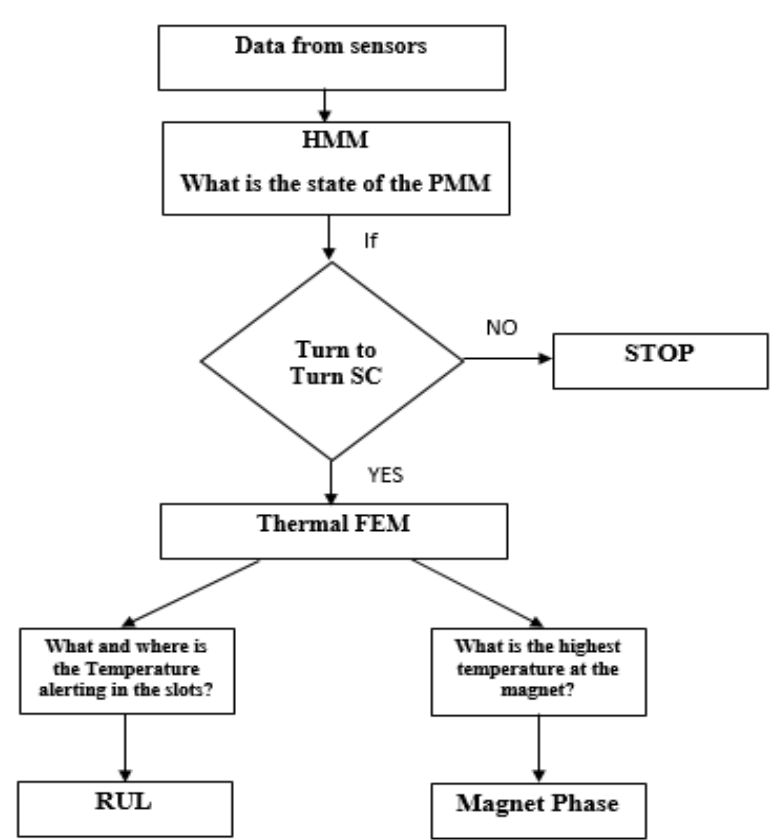
Figure 26. RUL calculation in the case of turn-to-turn short circuit.